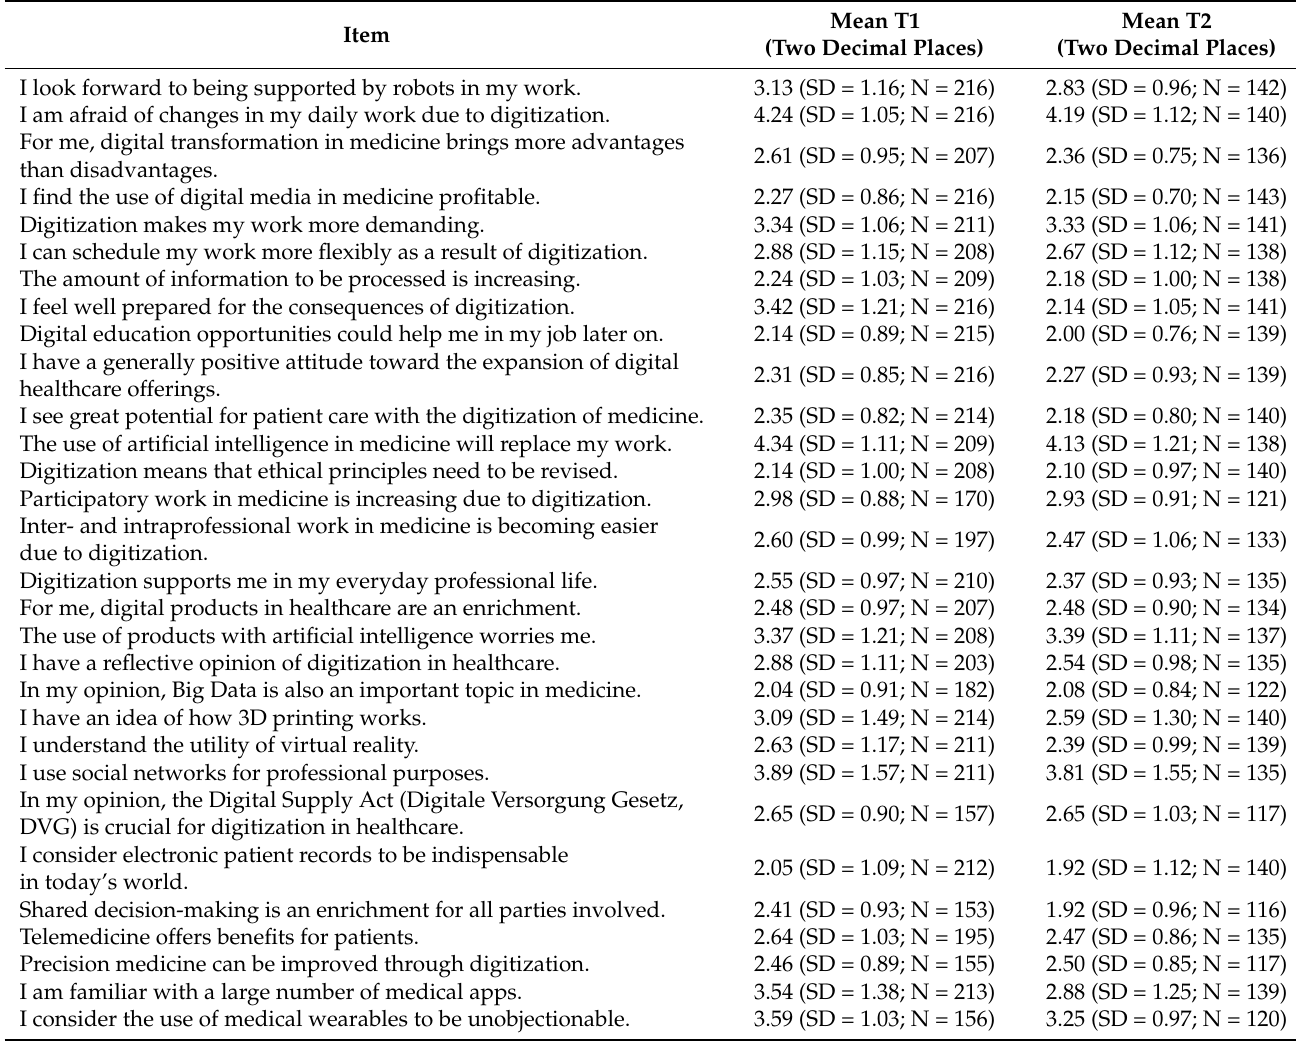
Table 2. The mean values for the content items at T1 and T2 (6-point Likert scale: 1 = strongly agree; 6 = strongly disagree). Item